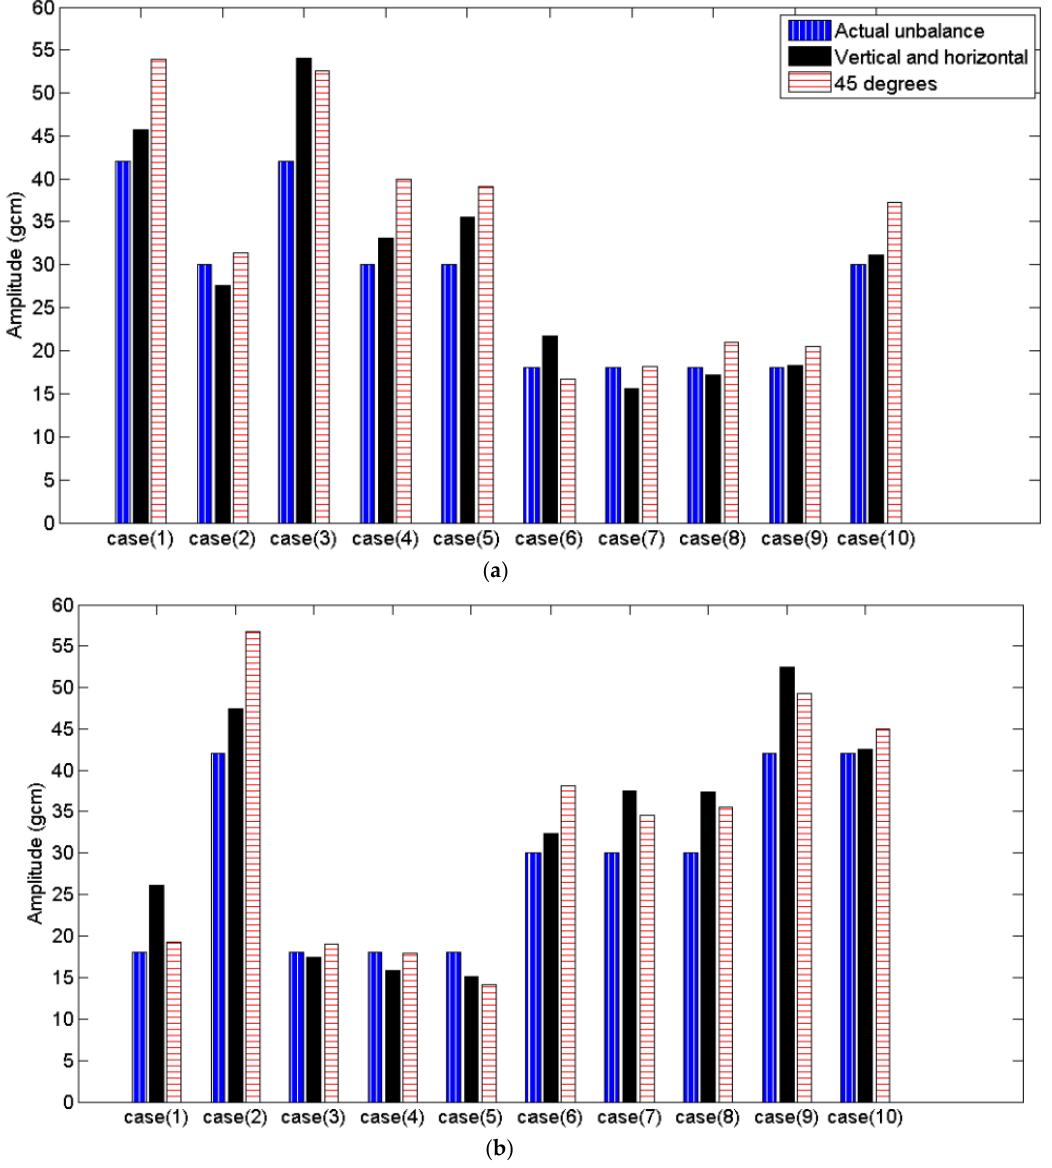
Figure 5. Grouped bar chart of the comparison between actual and estimated unbalances for ( a ) disc D1 and ( b ) disc D2.